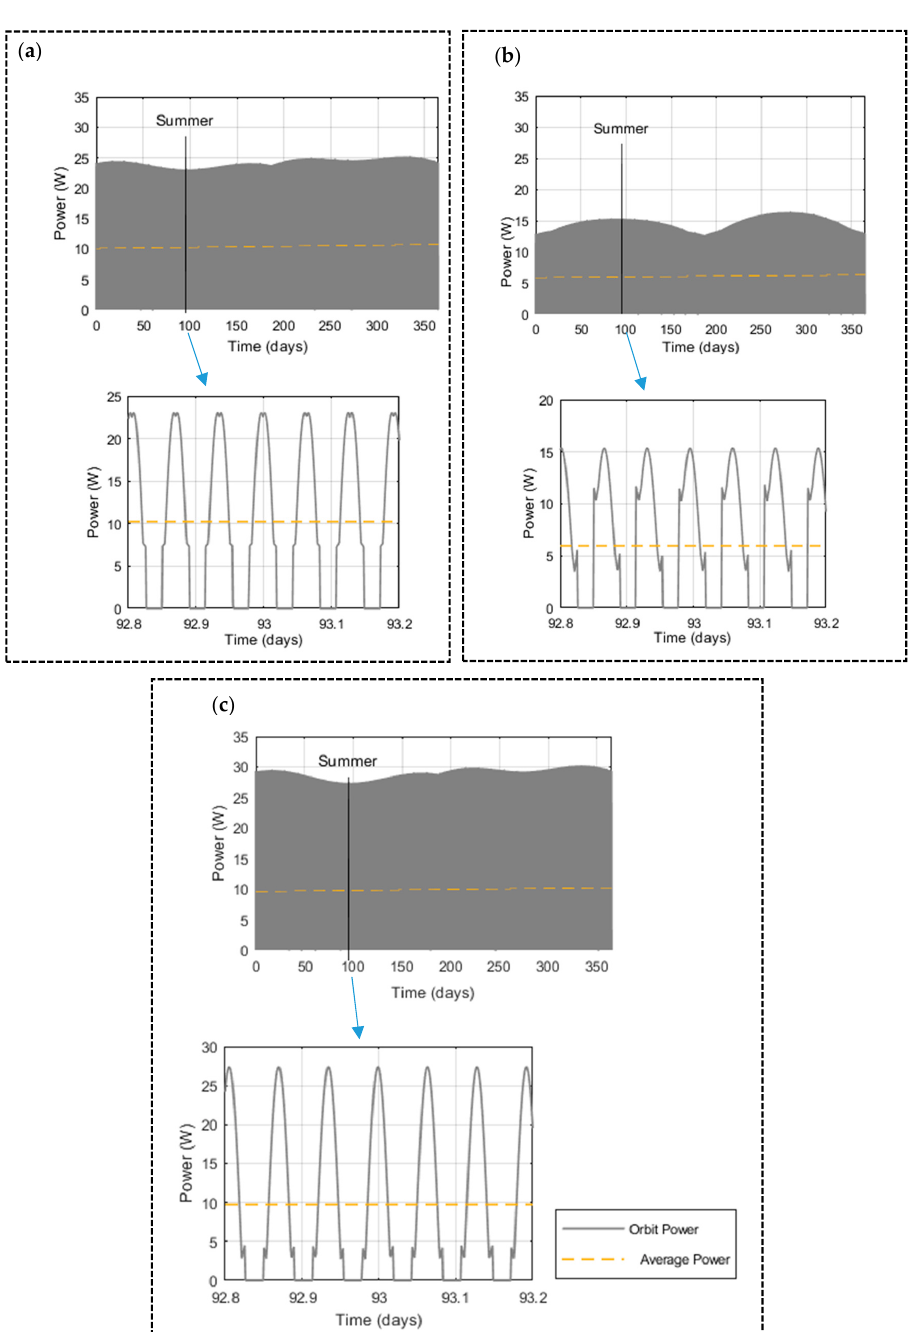
Figure 13. Solar power generation over one year period of ( a ) model 1, ( b ) model 2, and ( c ) model 3 .